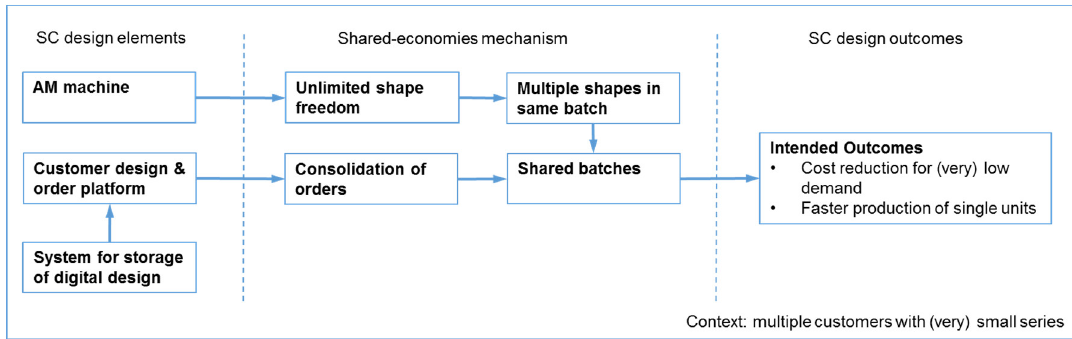
Figure 4. Shared-economies mechanism.